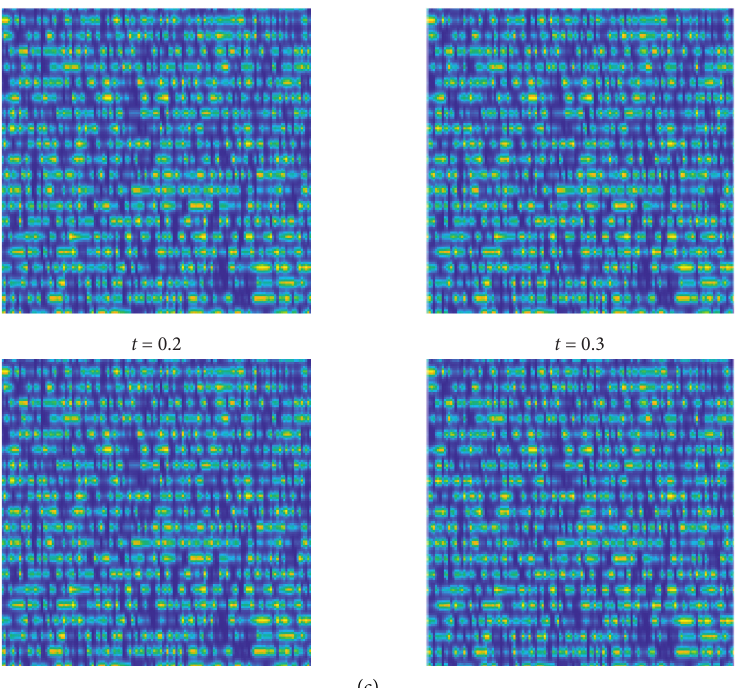
Figure 1: Numerical solution and pattern of Experiment 1 with initial condition η ( x,y, 0 ) � 0 . 6 sec h (( x /0 . 2 ) + y ) × r and ( N )